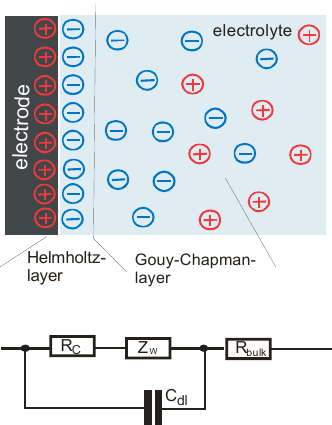
Fig.1: Interfacial layers between metal contact and electrolyte The potential within the Helmholtz layer changes linearly.